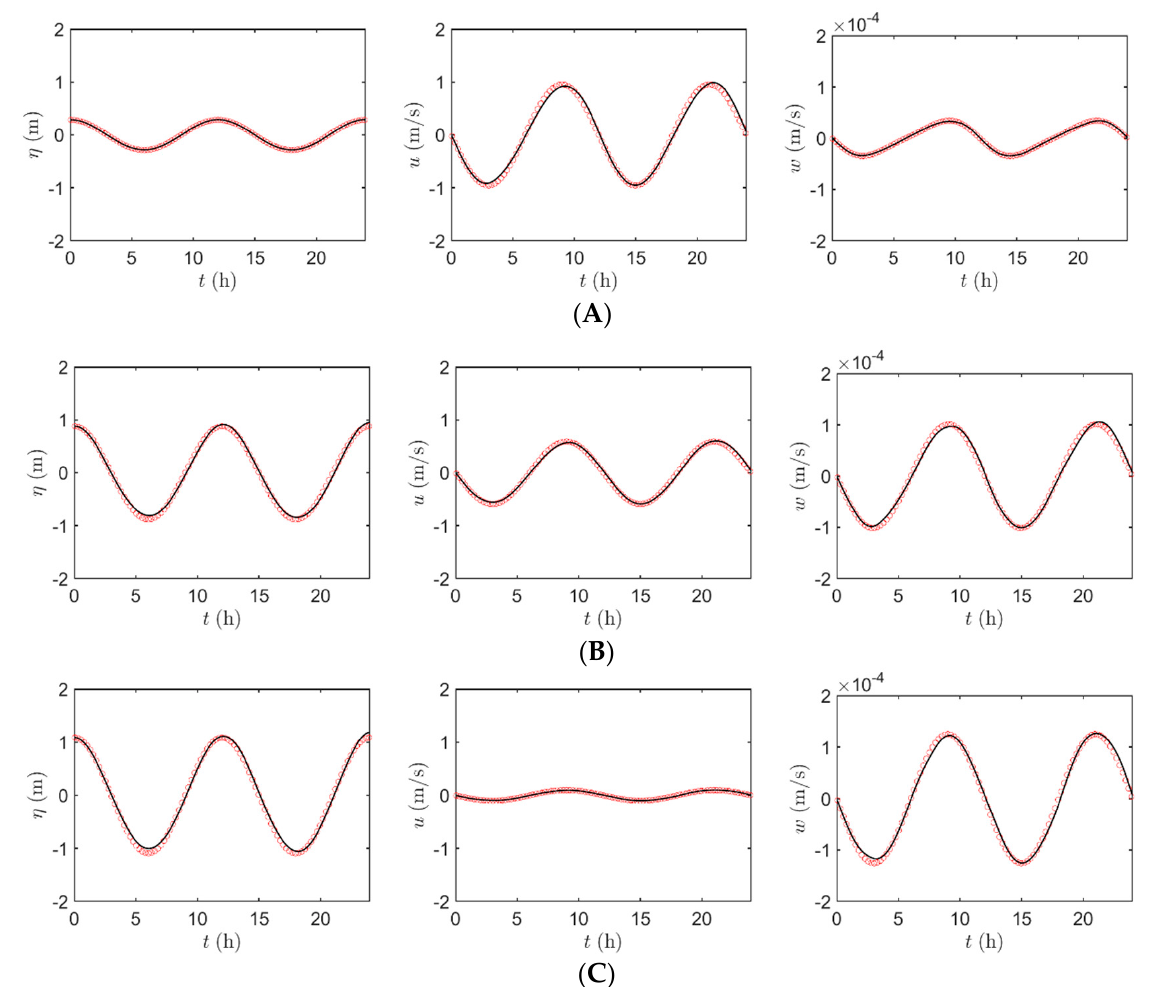
Figure 4. Comparison between the numerical result (black line) and the analytical solution (red circle) for surface elevation 𝜂 , horizontal velocity 𝑢 , and vertical velocity 𝑤 at Gauges ( A – C ).